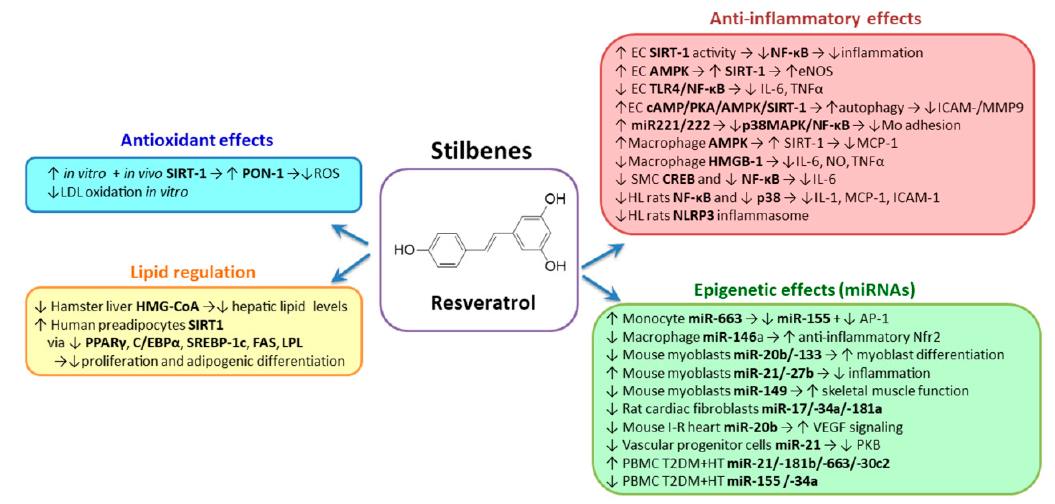
Figure 2. Resveratrol’s chemical structure and its demonstrated e ff ects of improving cardiovascular disease